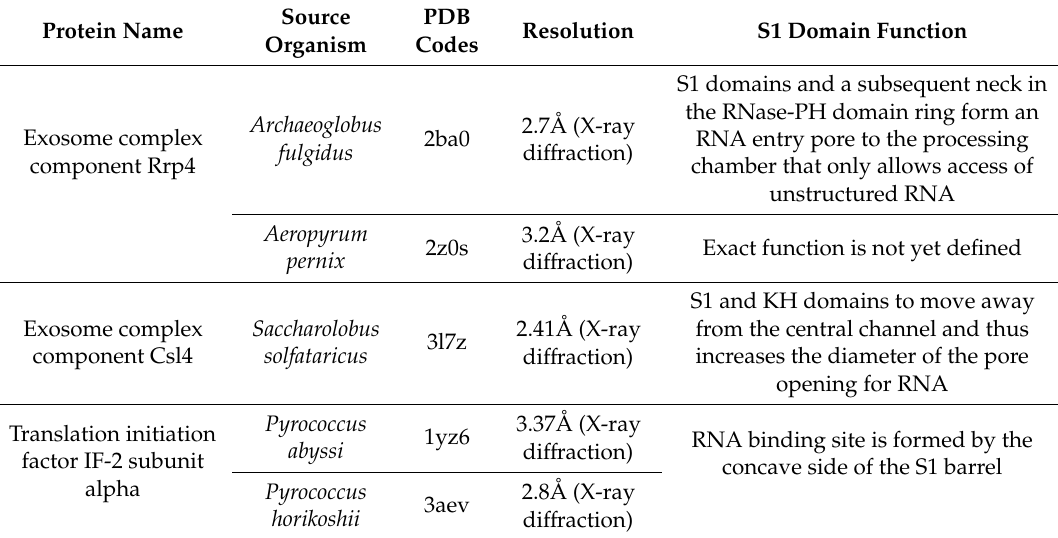
Table 3. Archaeal proteins containing the S1